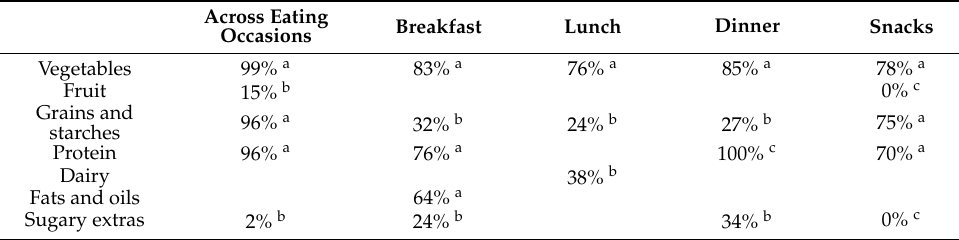
Table 3. Percentages of positive slopes observed for the relation between perceived meal colour